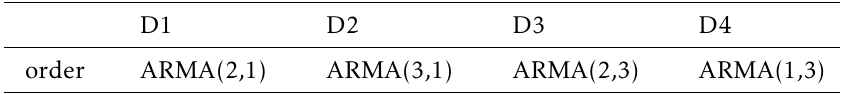
Table 2. Order of each part of the wavelet decomposition